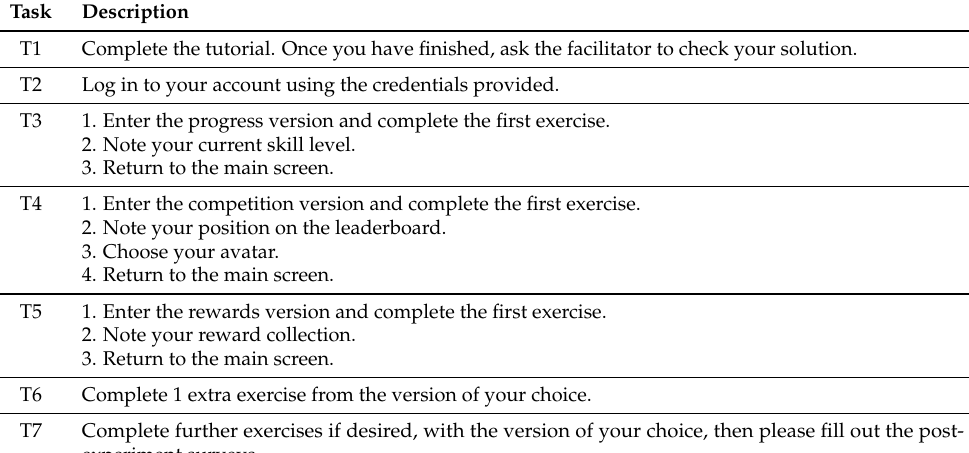
Table 3. Participant task